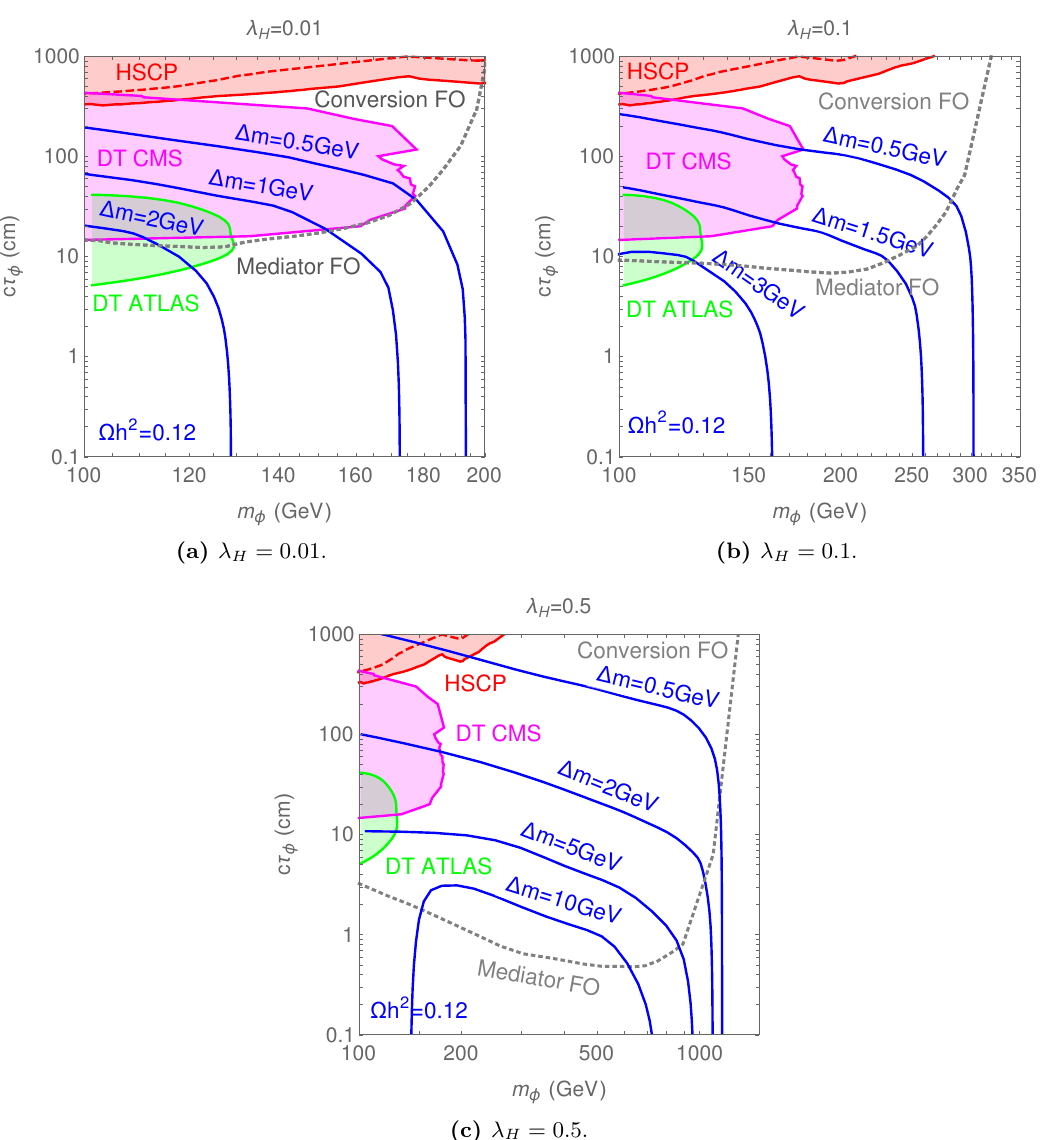
Figure 6 . Proper life time of the mediator as a function of the dark matter mass. Each panel corre- contributing to the mediator annihilation. The blue contours repro- sponds to a different value of λ H ) plane for different values of the mass-splitting ∆ m . duce the correct relic abundance in the ( m χ , cτ φ The gray dotted line separates the conversion driven (top) from the mediator annihilation driven (bottom) freeze-out regime. The excluded regions resulting from heavy stable particle (HSCP, red region) searches and disappearing tracks (DT, green region) searches at LHC are also shown. See text for